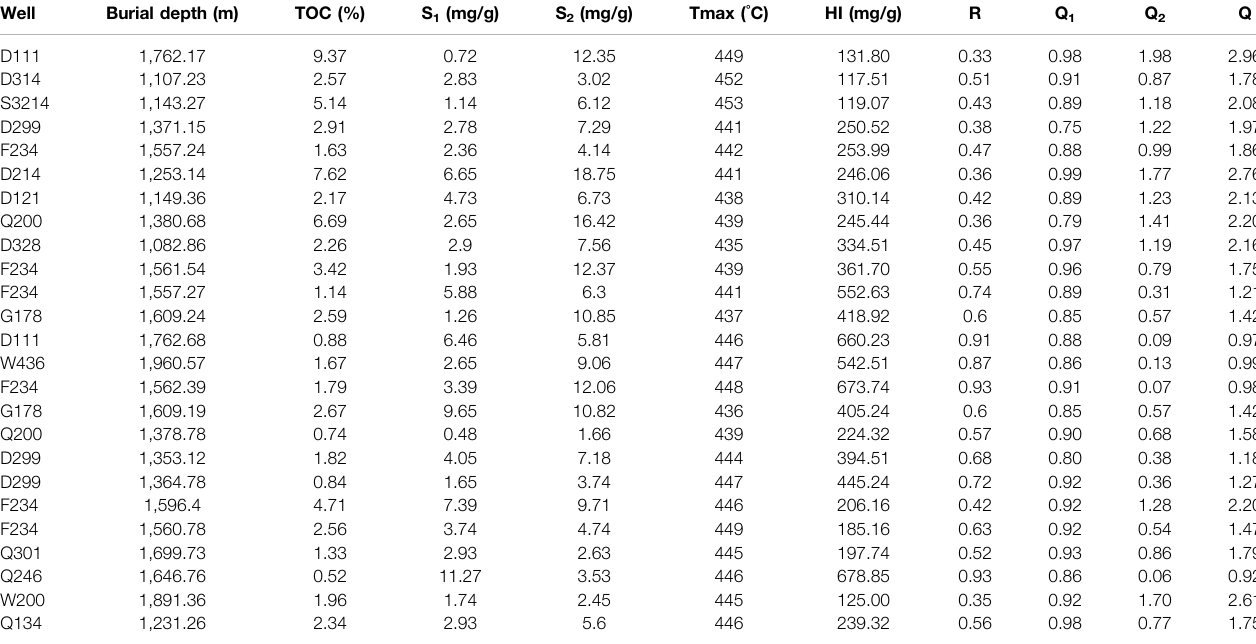
TABLE 2 | Geochemical parameters of organic matter in the Chang-7 shale. Well Burial depth (m) TOC (%)